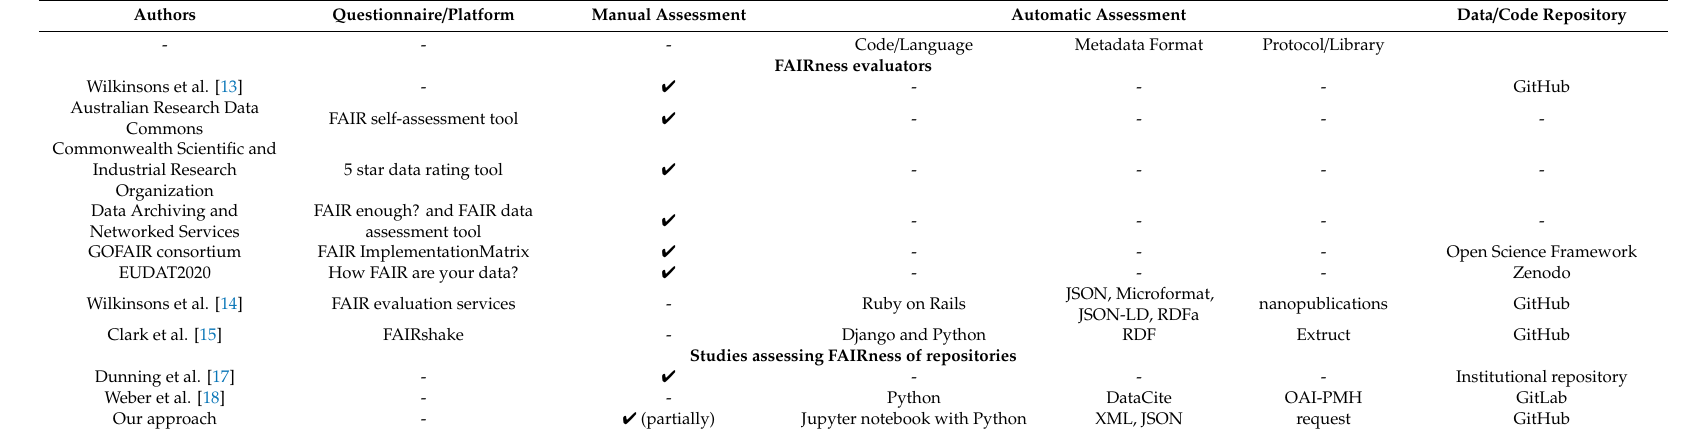
Table 1. Online FAIR (findable, accessible, interoperable, and reusable) evaluators and studies in the literature, which assess FAIRness of data repositories (the symbol (cid:52) indicates “yes”, the symbol - indicates